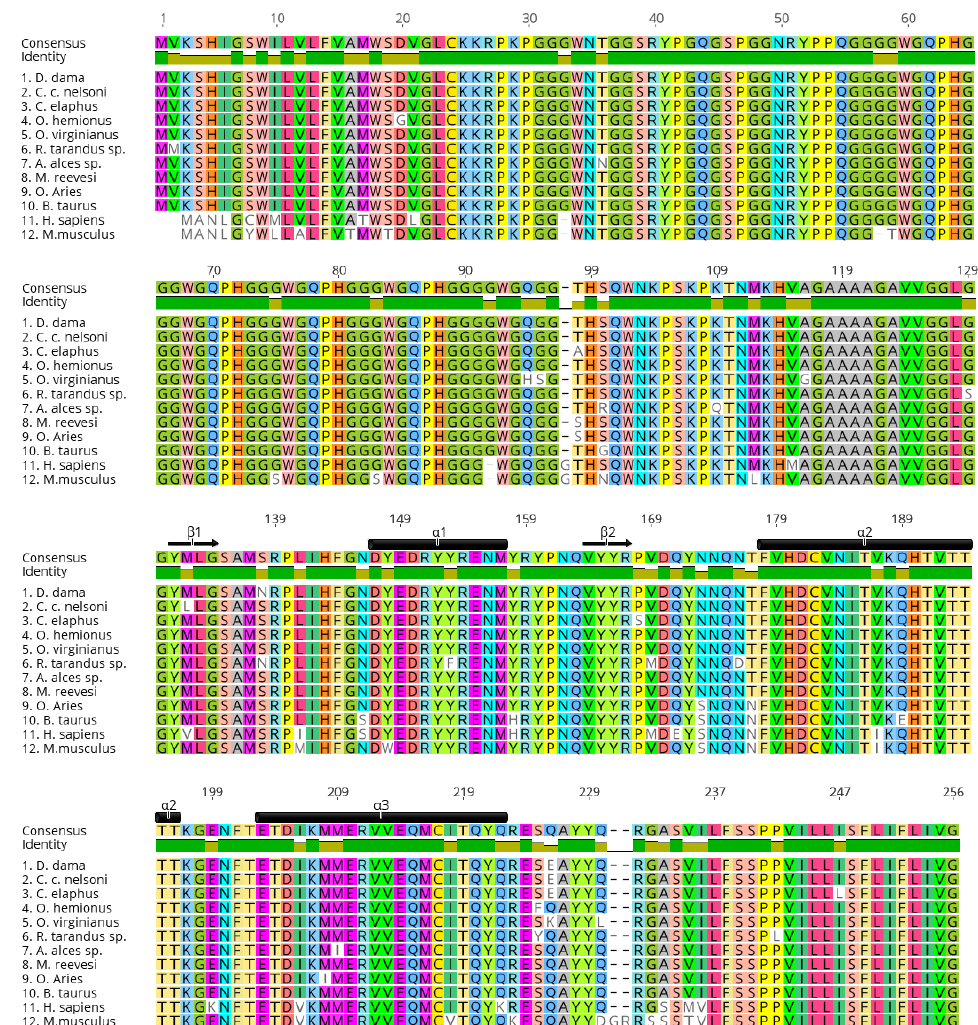
Figure 3. Cervid prion protein sequence alignment showing conserved homology between species. Protein alignment was performed in Geneious v10.2.6 (https://www.geneious.com) (accessed on 15 December 2020) using the ClustalW algorithm. Amino acid numbering is based on the consensus sequence. Amino acid variants were added manually to each sequence and are shown in white boxes. NCBI accession numbers used in this alignment: (1) QAU19527.1, (2)